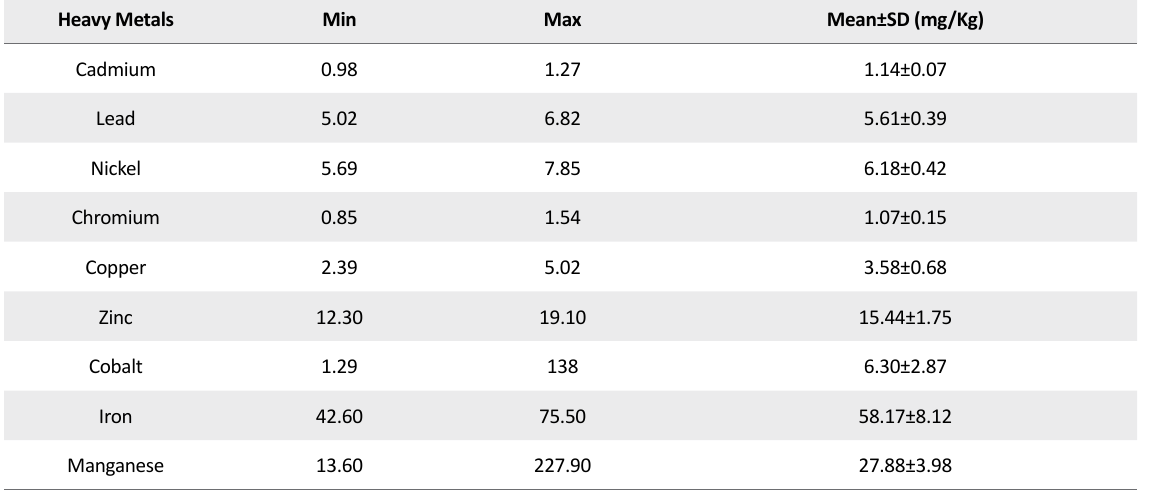
Table 2. Statistical parameters of heavy metals in wheat of Weiss